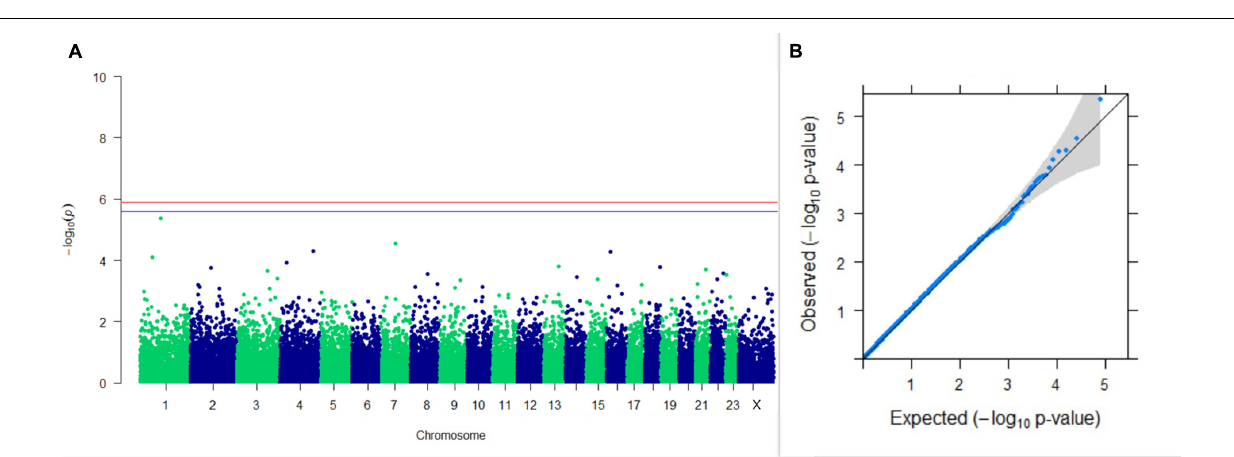
variation explaining PCs (PC 1 and PC 2 ) of TDMY, TDFP, and